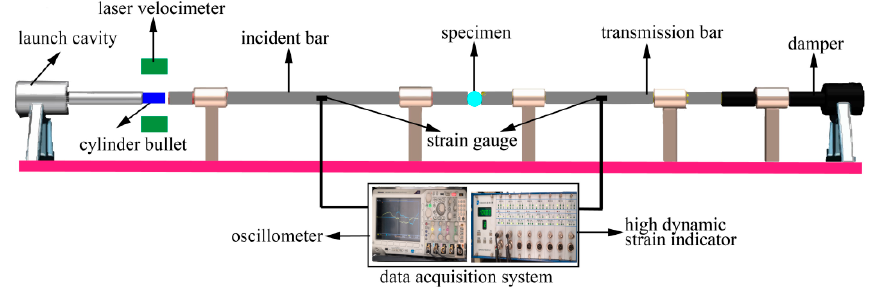
Figure 1. Schematic diagram of the split Hopkinson pressure bar (SHPB) system.